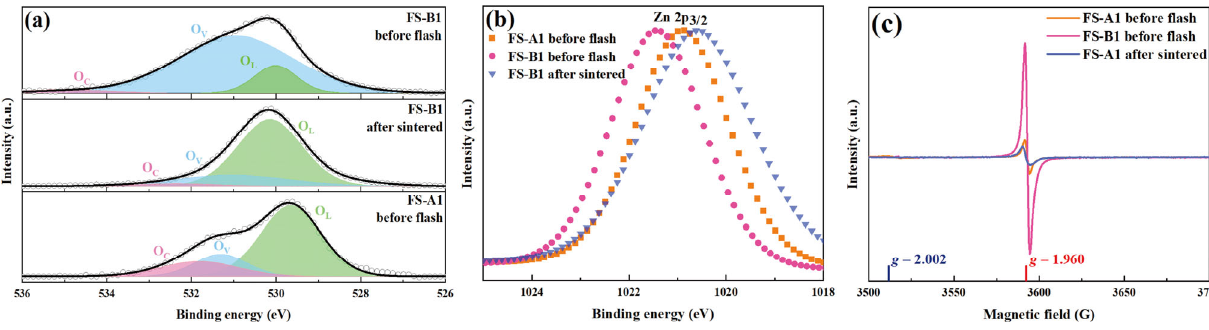
Fig. 3 Characterization of ZnO samples. XPS spectra of (a) O 1s and (b) Zn 2p. (c) EPR